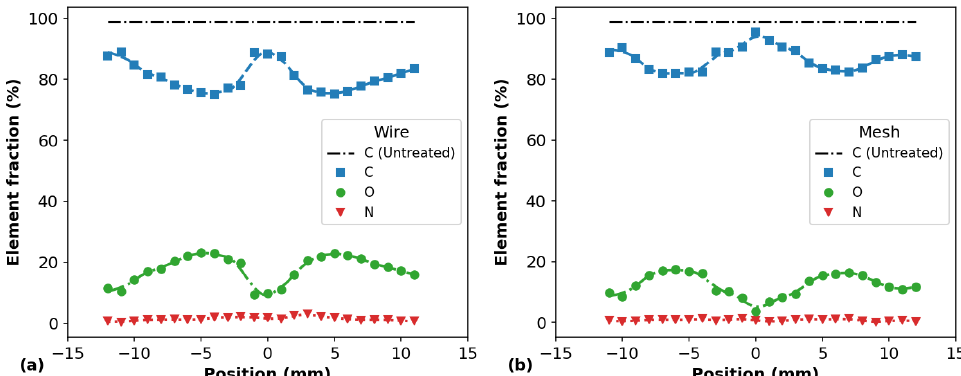
Figure 10. Fractions of the elements detected on the on the surface of PP samples for different positions through XPS measurements for ( a ) the wire configuration and ( b ) the mesh one.